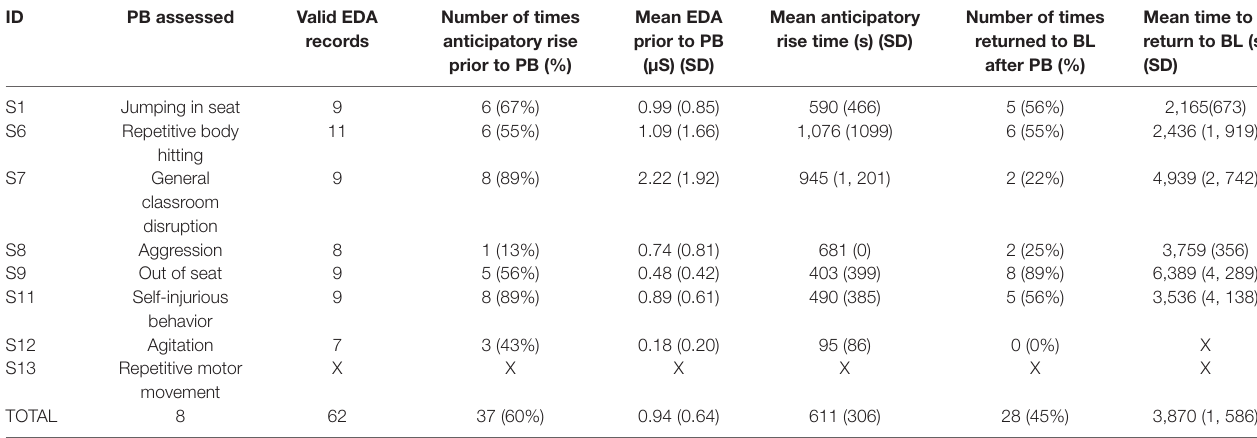
TABLE 2 | Frequency and percentage of the occurrence of an anticipatory rise in EDA prior to the problem behavior, mean anticipatory rise time, number of times that a student returned to baseline EDA after engaging in problem behavior, and the mean time for EDA to return to baseline. Note for S13, no statistics for anticipatory rise and return to baseline were able to be calculated as the student’s repetitive behavior was continuous for the duration of each